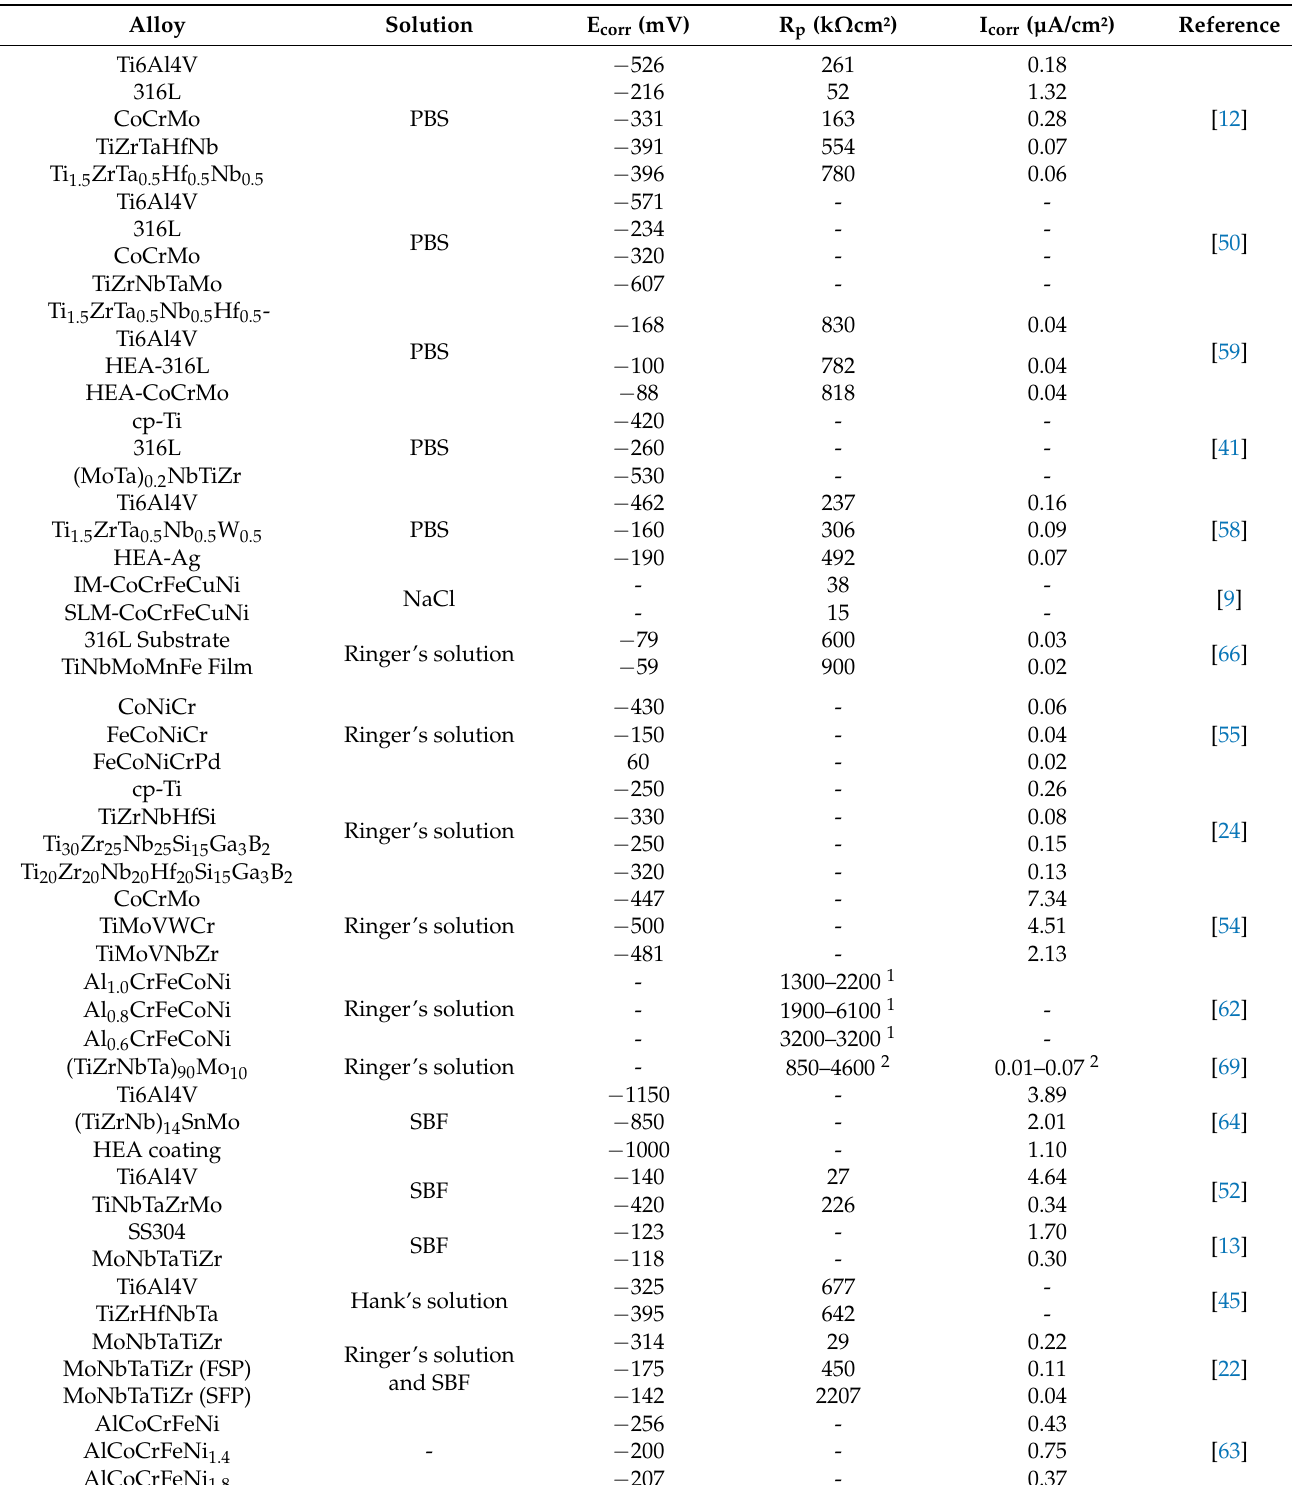
Table 8. Anticorrosive performance of bioHEAs and conventional